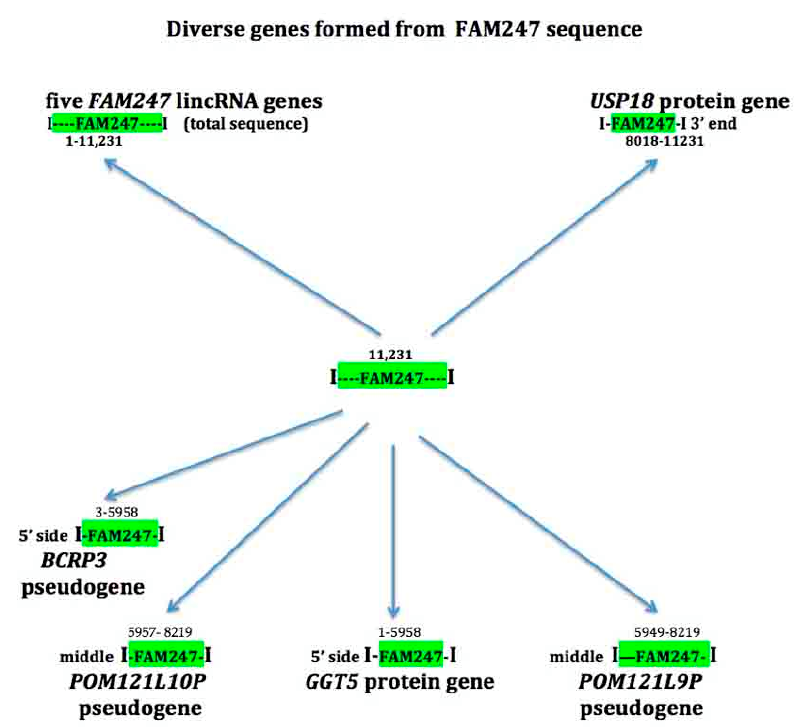
Figure 2. Protein genes, lincRNA genes, and pseudogenes that stem from the FAM247 sequence and contain di ff erent sections of the FAM247 sequence (shown in bp position numbers above FAM247 highlighted in green). Analysis of FAM247 by the RepeatMasker program: RepeatMasker http: // www.repeatmasker.org / cgi-bin / WEBRepeatMasker shows the presence of Alu sequences in the FAM247 sequence at bp positions 6007–6285 and 8063–8374, the regions close to breaks. The